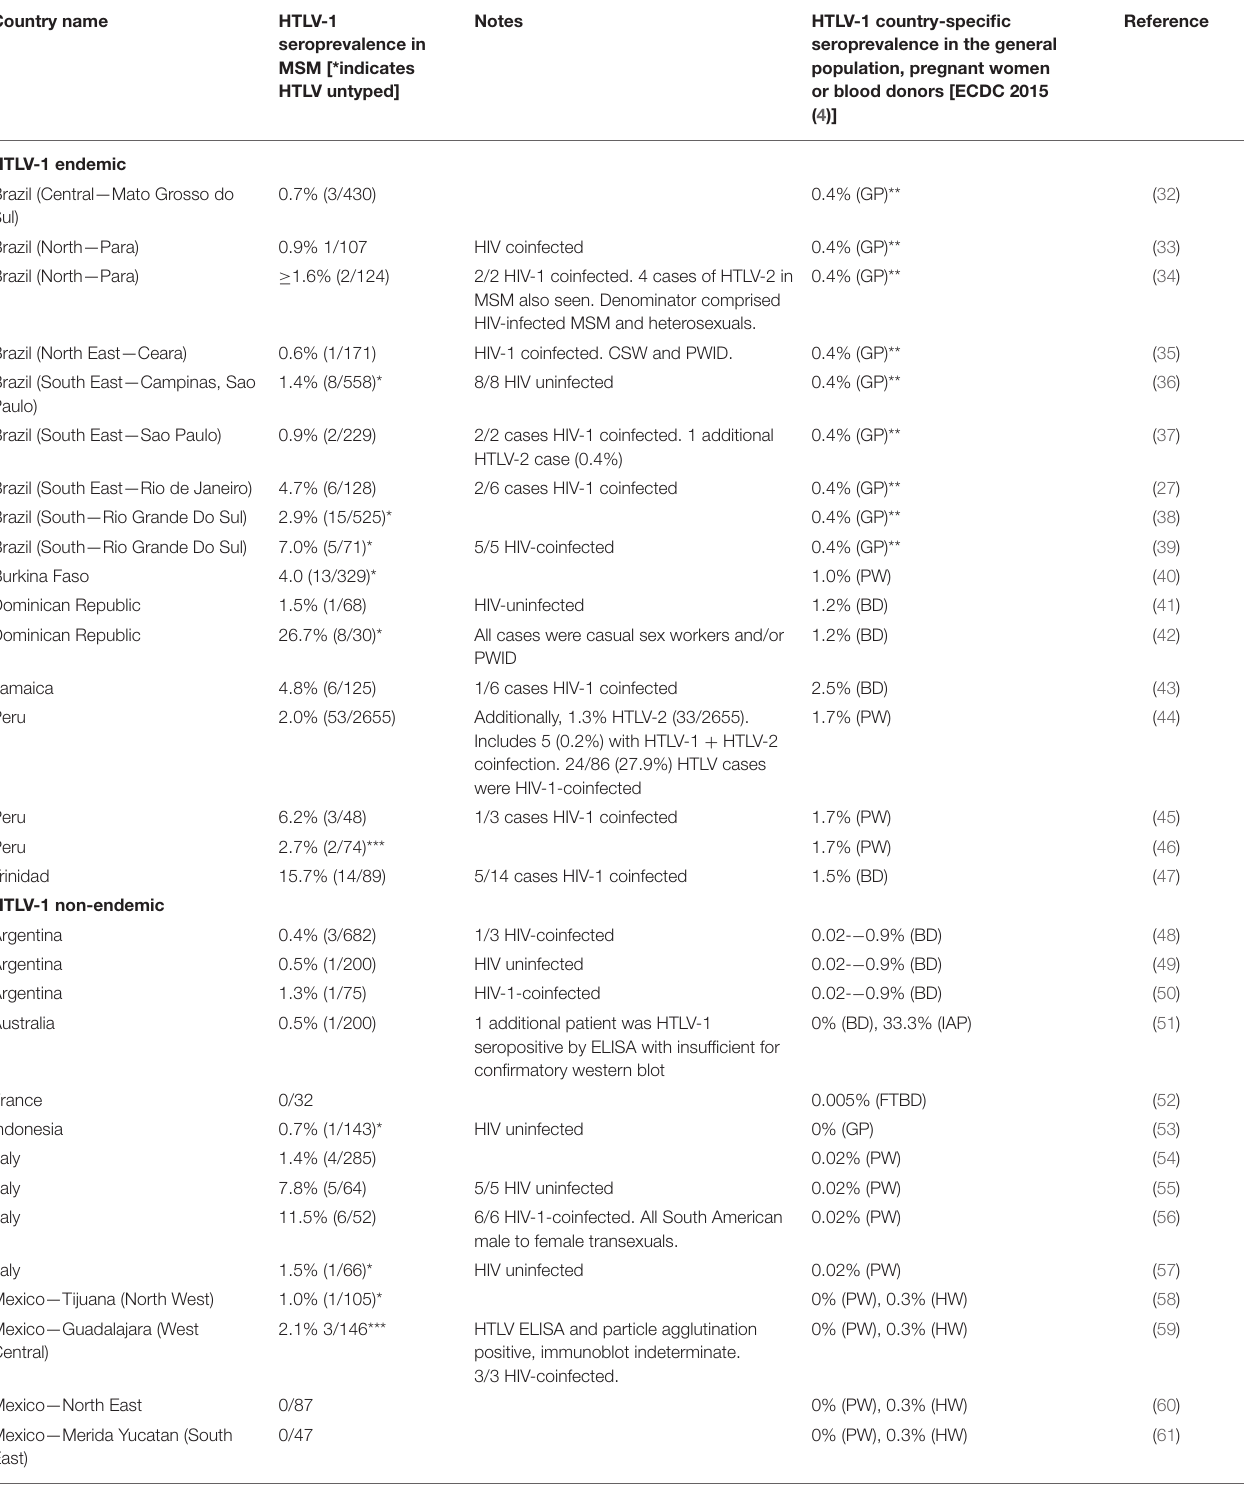
TABLE 1 | HTLV-1 seroprevalence studies amongst men who have sex with